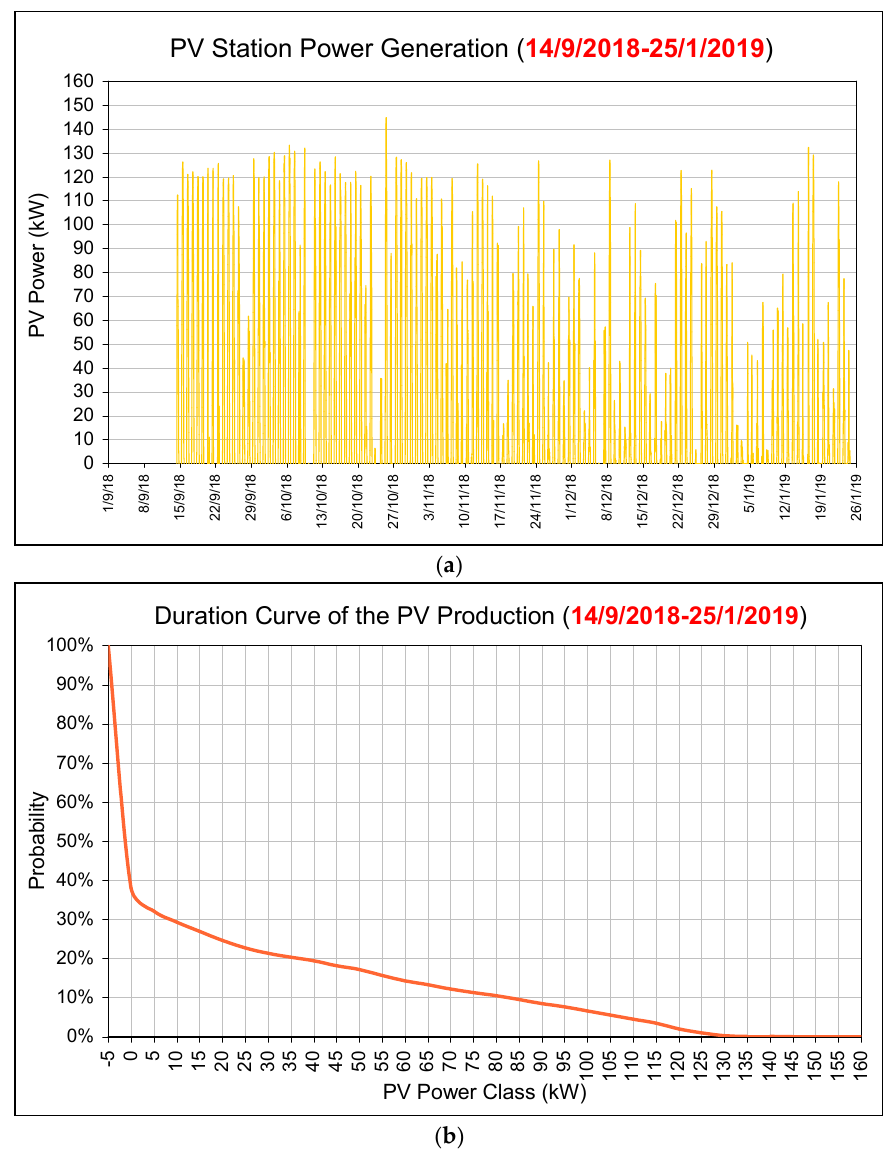
Figure 21. ( a ) PV station power generation; ( b ) relevant duration curve.